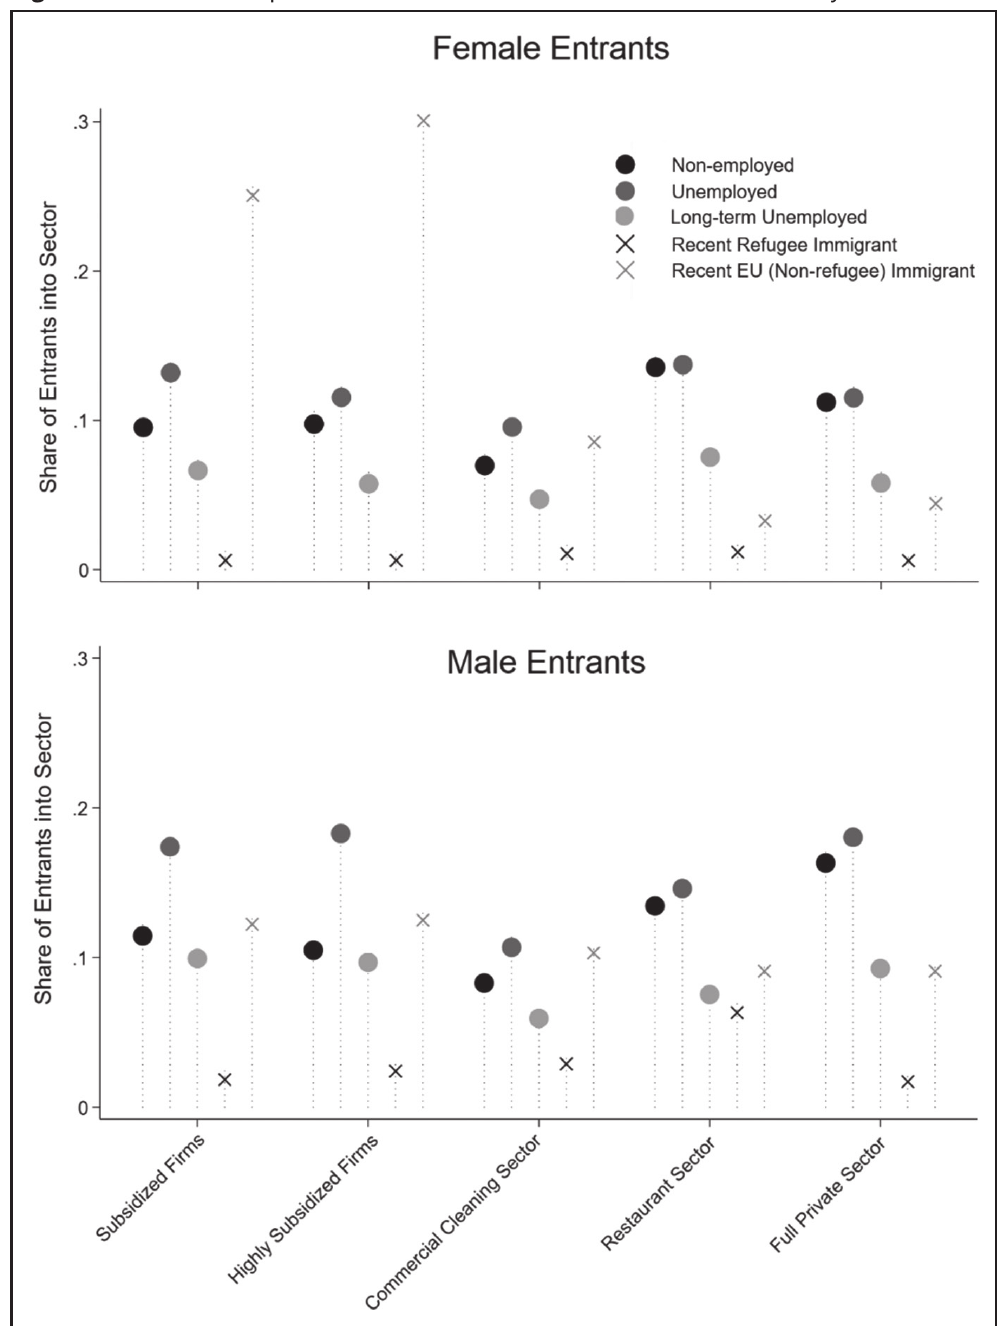
Profile of previous labor market statuses of sector entrants by sex at